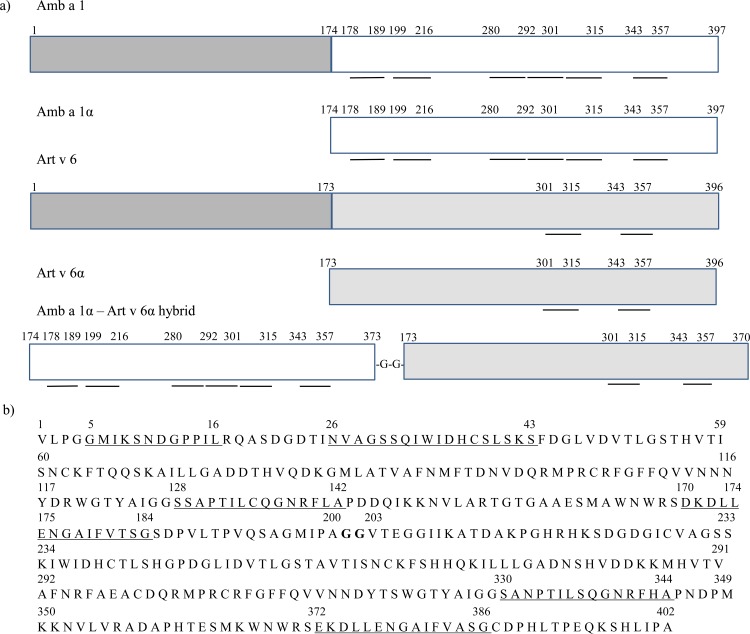
Amb a 1α, Art v 6α and hybrid sequences.(A) Construction scheme of the Amb a 1, Art v 6 derivatives. Amb a 1α and Art v 6α consisted of amino acids 174–397 of Amb a 1 (white) and 173–396 of Art v 6 (grey), respectively. Fragments of Amb a 1α (174–373) and Art v 6 α (173–370) were reassembled to form the hybrid molecule. T cell activation regions showing >65% cross-reactivity are underlined. (B) Amino acid sequence of hybrid molecule consisting of Amb a 1α, residues GG acting as a linker (bold) and Art v 6α. Cross-reactive T cell epitopes of Amb a 1α and Art v 6α with proliferative responses > 50% are shown underlined. Numbers correspond to aa in either Amb a 1 or Art v 6 sequence.